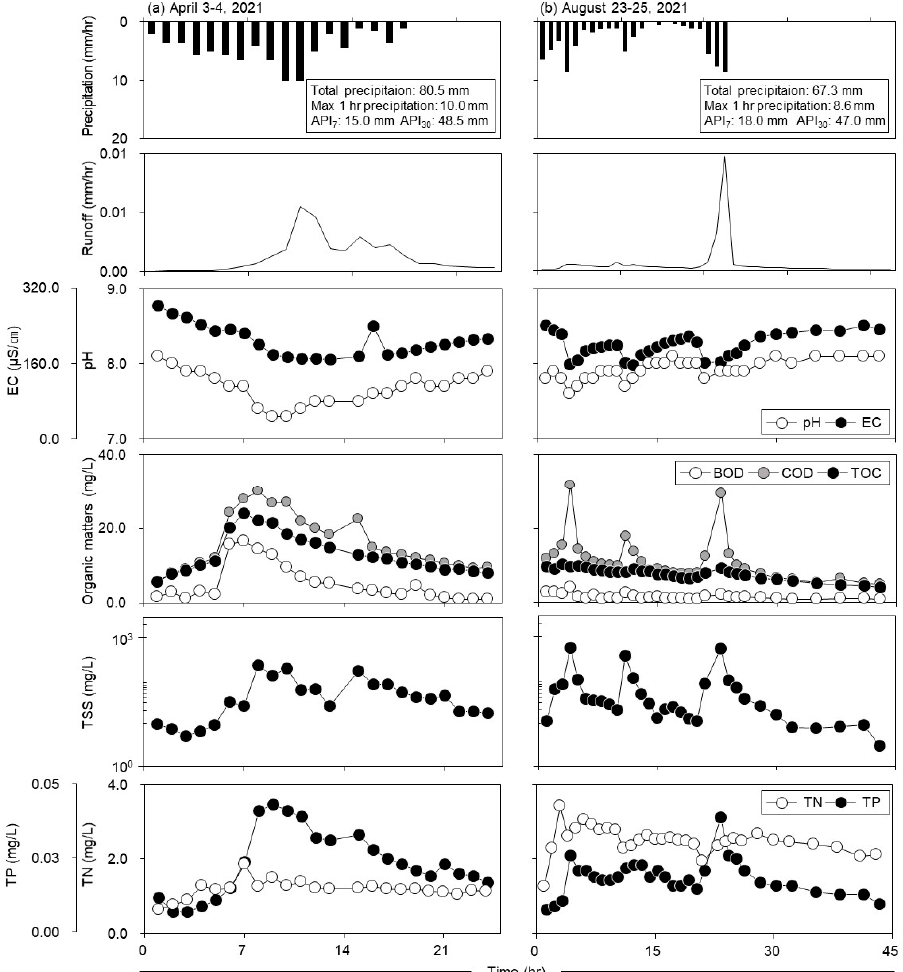
Figure 3. Changes in headwater stream quality in selected rainfall events in the immediate post ‐ fire period. ( a ) E3 (3 − 4 April 2021) and ( b ) E9 (23 − 25 August 2021). Less increase in organic matter